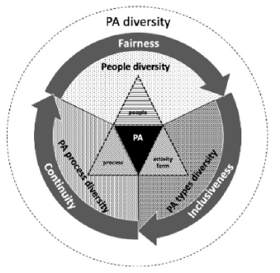
Figure 1. The conceptual model of PA diversity.